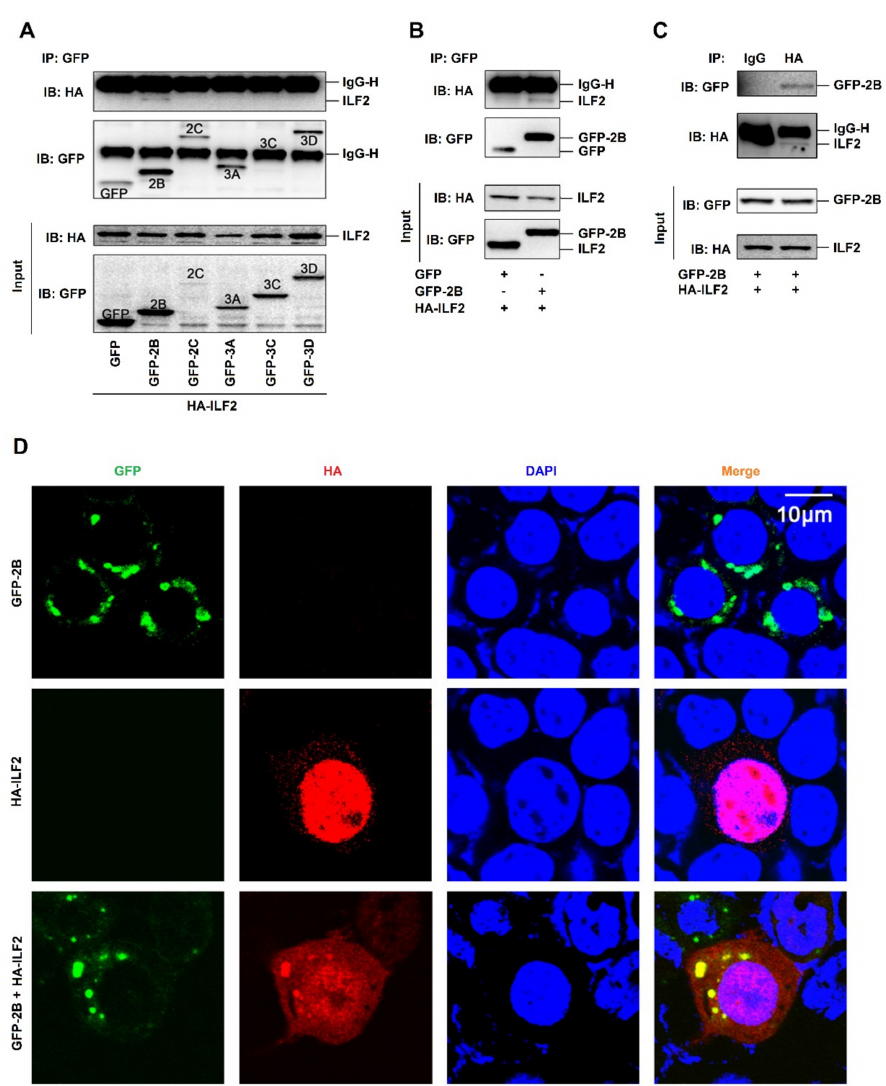
Figure 4. EV71 2B interacts and colocalizes with ILF2 in the cytoplasm. ( A ) Human embryonic kidney (HEK293T) cells co-transfected with plasmids encoding HA-ILF2 and each of EV71 nonstructure proteins, GFP-2B, GFP-2C, GFP-3A, GFP-3C, and GFP-3D. The GFP-tag, GFP-2B, GFP-2C, GFP-3A, GFP-3C, GFP-3D, and HA-ILF2 proteins were subjected to coimmunoprecipitation (Co-IP) assay with anti-GFP antibody or with IgG as a negative control. The levels of GFP-tag, GFP-2B, GFP-2C, GFP-3A, GFP-3C, GFP-3D, and HA-ILF2 proteins were detected by Western blot analyses using anti-GFP antibody or anti-HA antibody, as indicated. ( B and C ) HEK293T cells co-transfected with pHA-ILF2 and pGFP-tag or pGFP-2B. The GFP-tag, GFP-2B, and HA-ILF2 proteins were subjected to Co-IP assay with anti-GFP antibody ( B ). The GFP-tag, GFP-2B, and HA-ILF2 proteins were subjected to Co-IP assay with anti-HA antibody or with IgG as a negative control ( C ). The levels of GFP-tag, GFP-2B, and HA-ILF2 proteins were measured by Western blot using anti-GFP antibody or anti-HA antibody, as indicated. ( D ) HEK293T cells transfected with pGFP-2B alone or pHA-ILF2 alone or co-transfected with pGFP-2B and pHA-ILF2 together. The localization and distribution of EV71 2B protein (green), ILF2 protein (red), and the nuclei (blue) were visualized under a laser scanning confocal